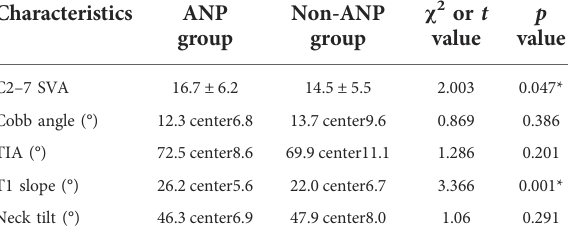
TABLE 4 Radiographic measurement of all the patients preoperatively at the sagittal plane.